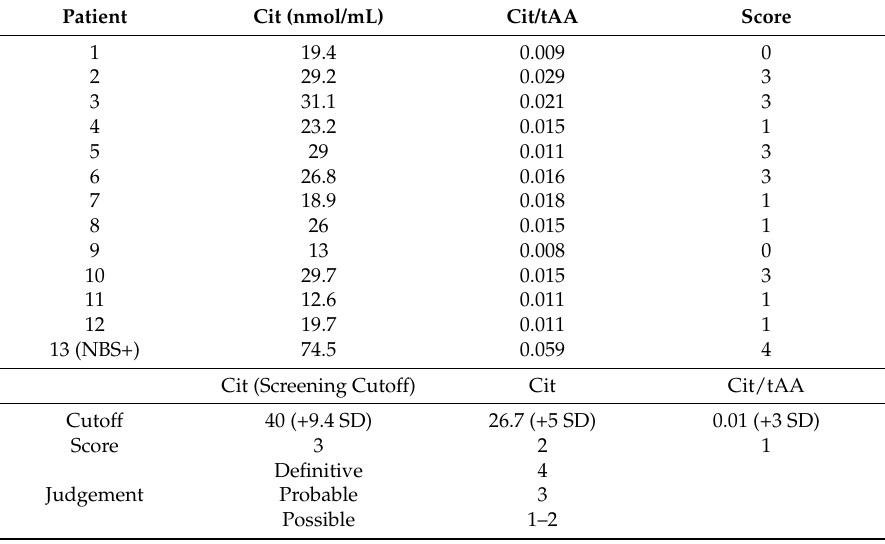
Table 4. Estimated NICCD